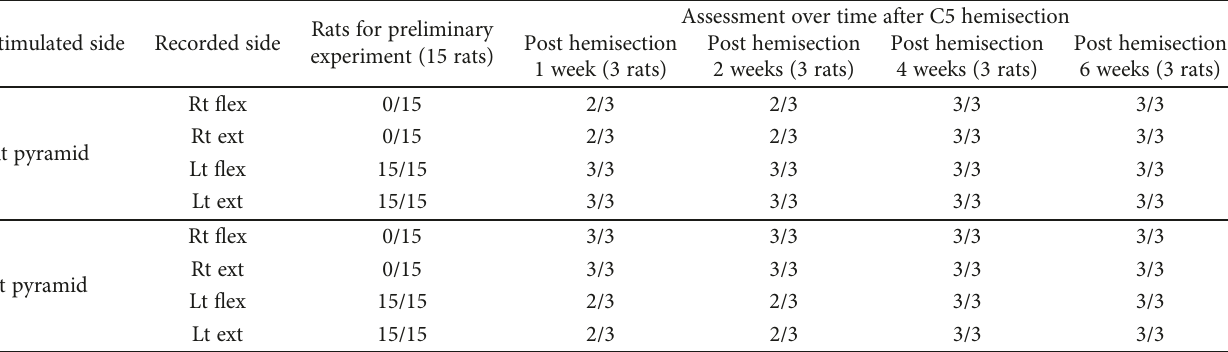
Table 1: Existence or nonexistence of CMAPs in the group of rats for preliminary experiment and the group of rats for assessment over time after C5 hemisection. Stimulated